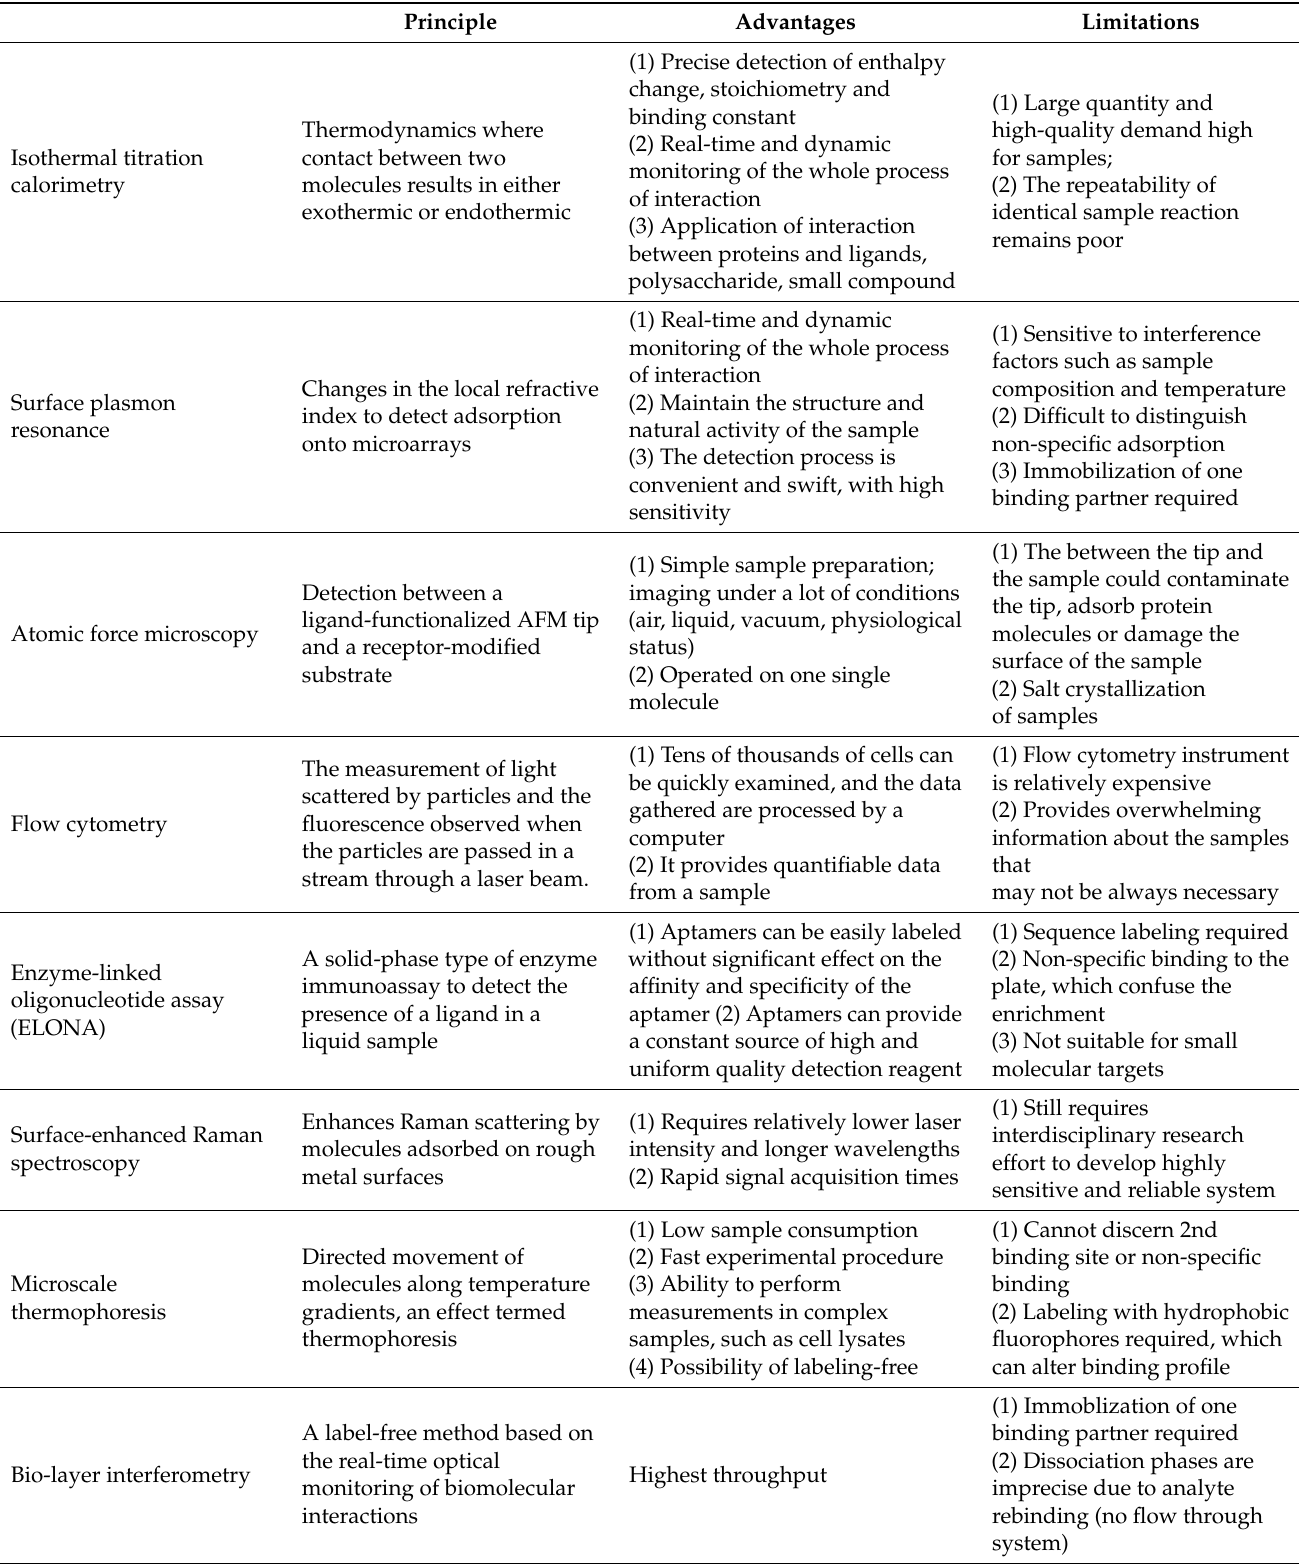
Table 3. Advantages and disadvantages of different methods of detecting binding